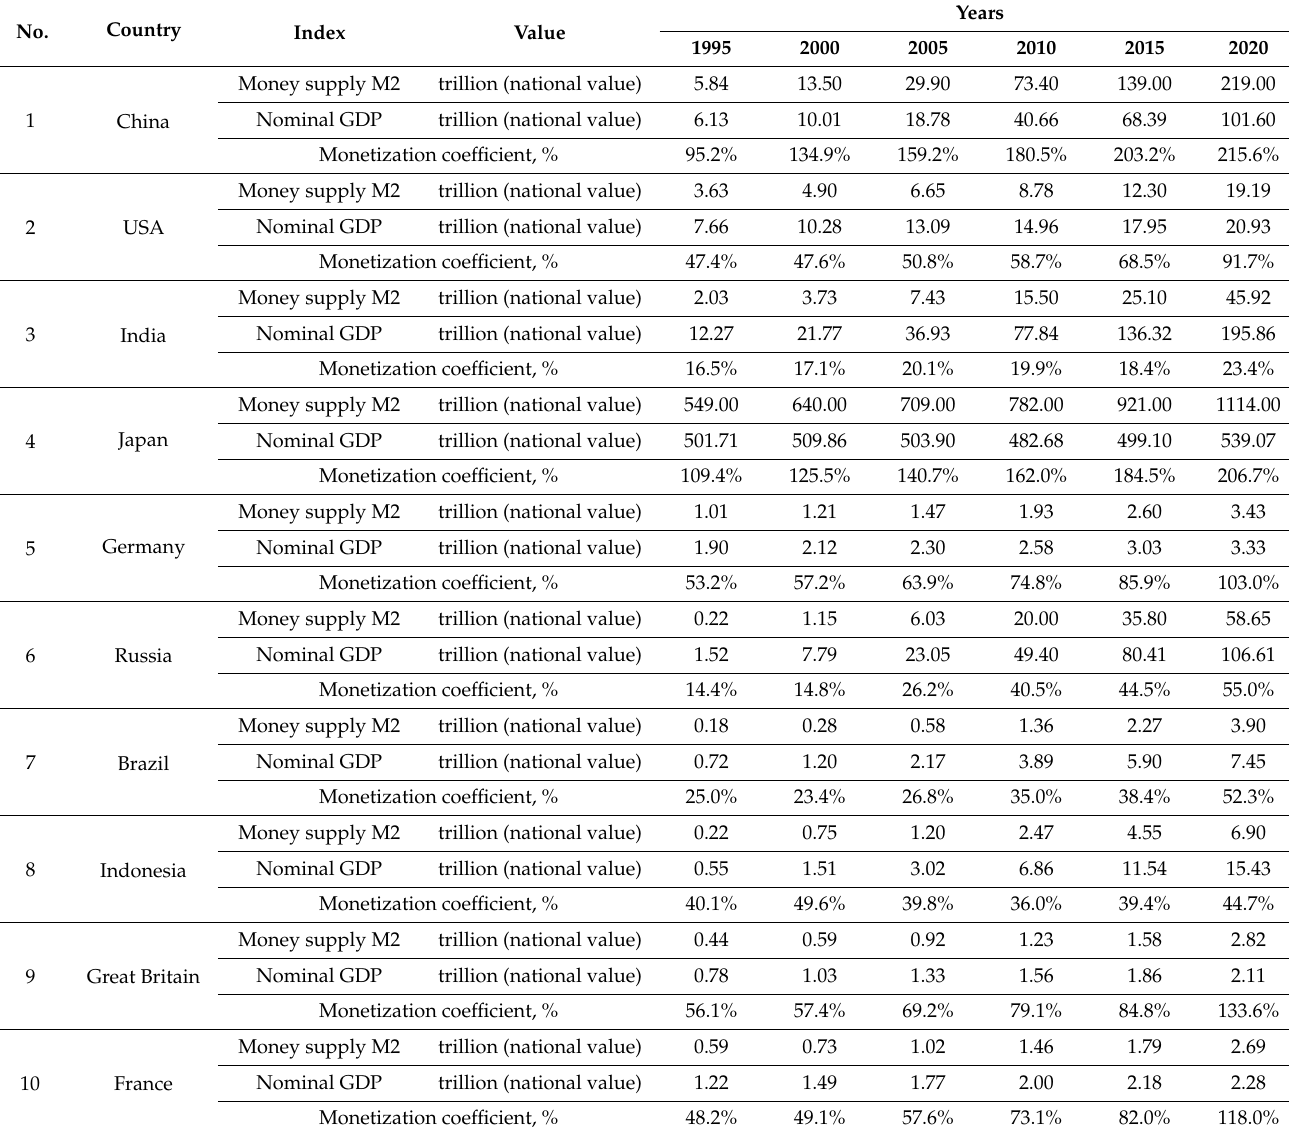
Table 5. Monetization coefficient dynamics (1995–2020)